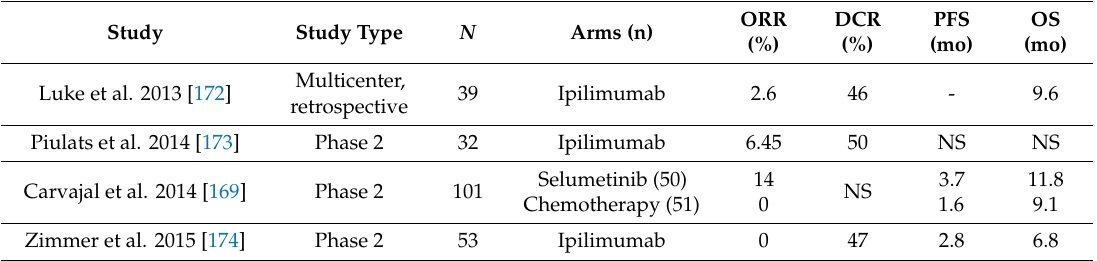
Table 4. Selected studies for therapy of uveal